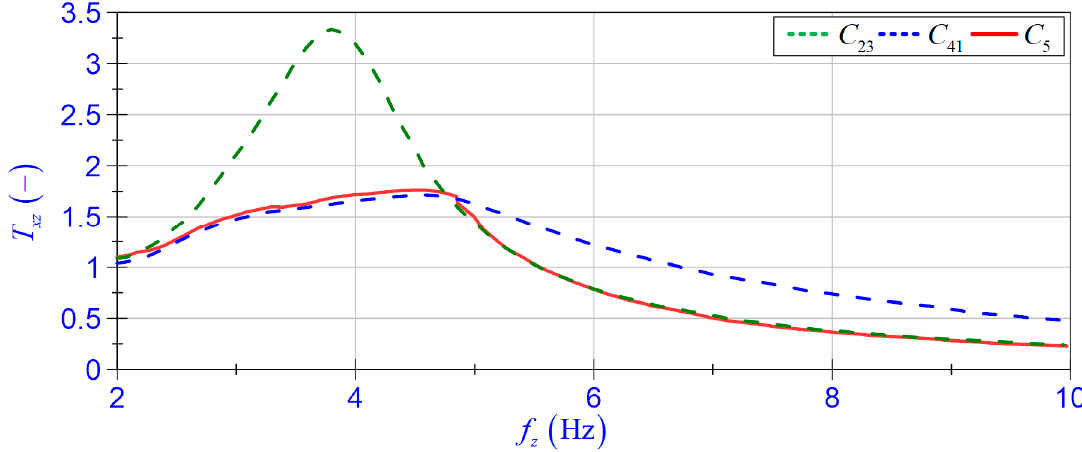
Figure 18. Displacement transmissibility T xz vs. frequency f z . Table 3. The standard deviation of measured velocity and power consumption of transducers.